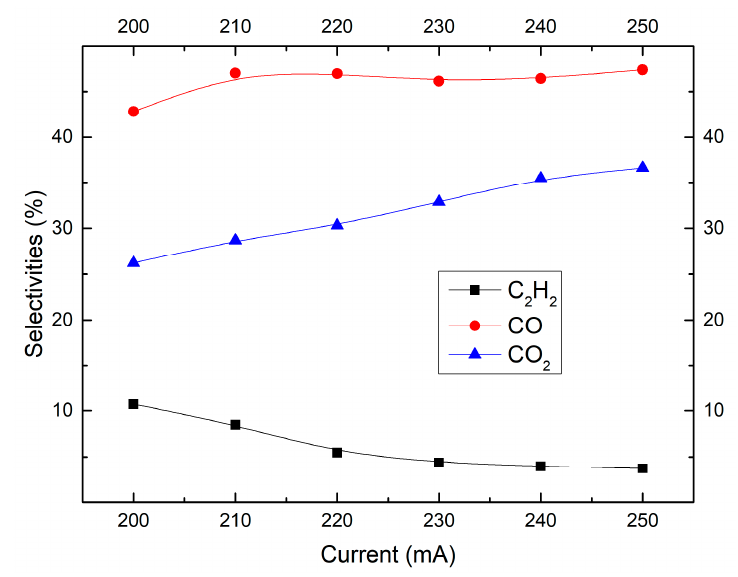
Figure 16. Effect of discharge current on the selectivity of C 2 H 2 , CO and CO 2 .